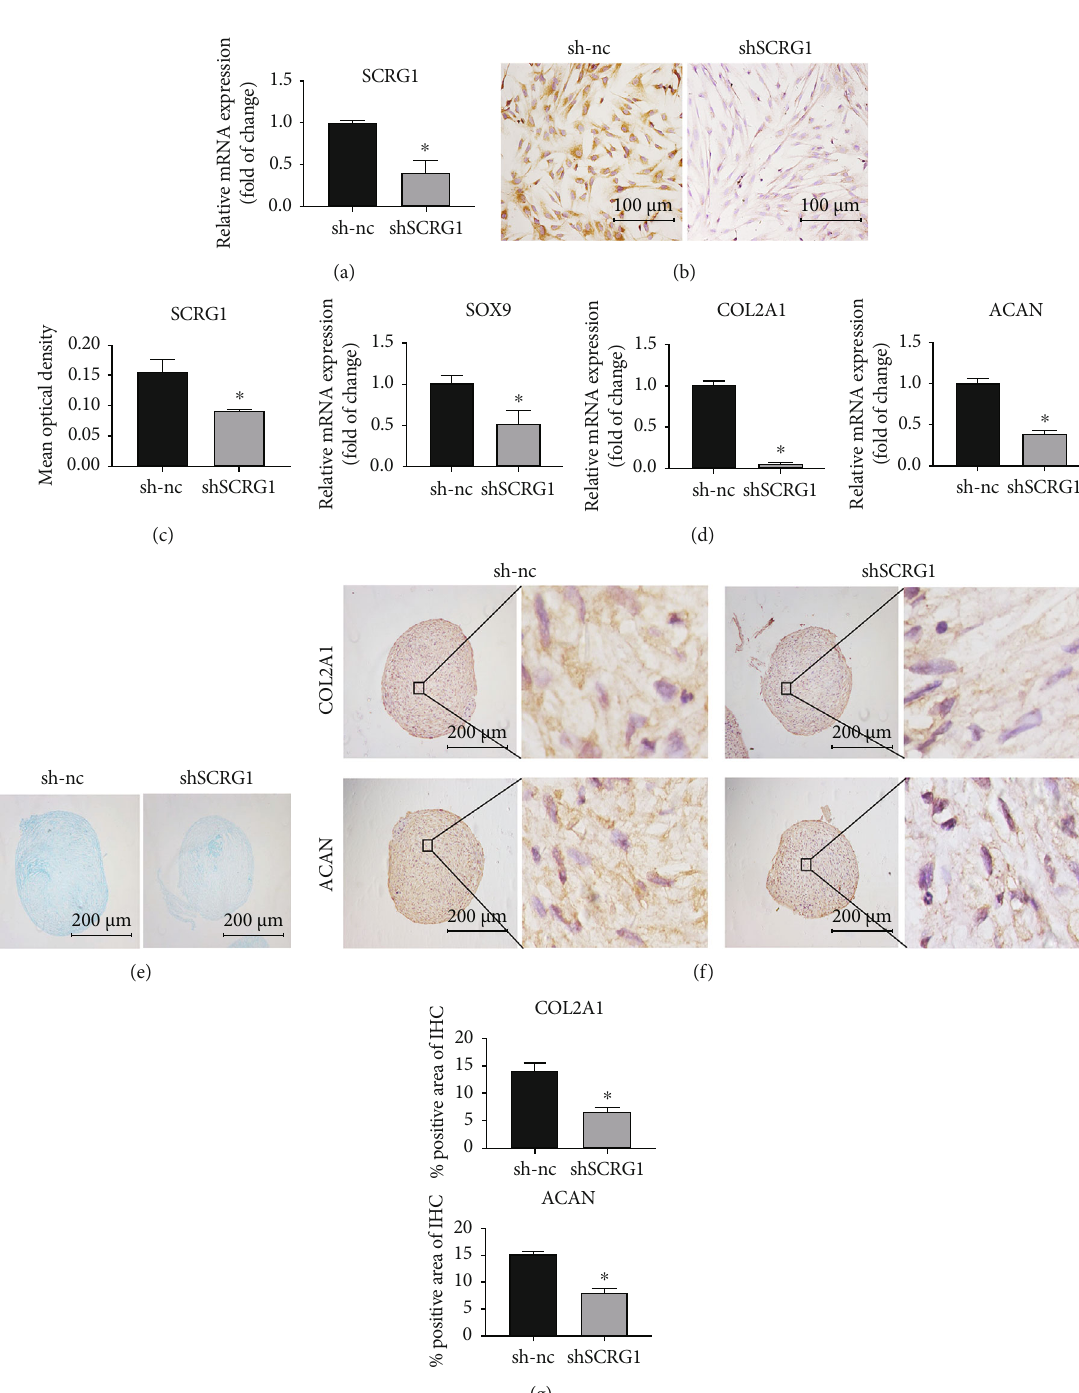
Figure 3: SCRG1 knockdown inhibited chondrogenic di ff erentiation potential of UCMSCs. (a – c) mRNA and protein expression levels of SCRG1 were decreased after transfection with SCRG1 shRNA, detected by qRT-PCR and IHC. Scale bar = 100 μ m . (d) SOX9 , COL2A1 , and ACAN mRNA levels decreased following SCRG1 knockdown. (e) Alcian Blue staining at day 21. Results showed that glycosaminoglycan synthesis decreased signi fi cantly after SCRG1 knockdown. (f, g) Protein levels of COL2A1 and ACAN detected by IHC at day 21 decreased after SCRG1 knockdown. Scale bar = 200 μ m . Experiments were repeated three times; ∗ P < 0 : 05 ( t